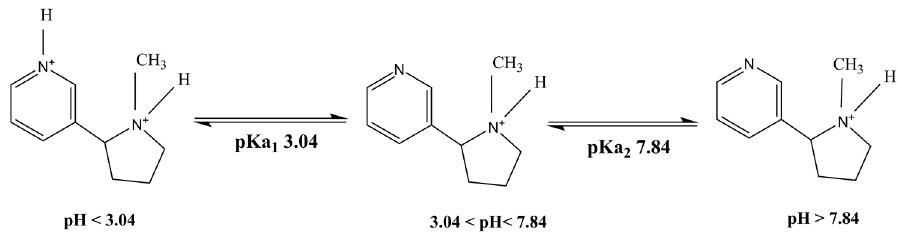
Figure 2. Representation of chemical structure of nicotine with different charged species [10].